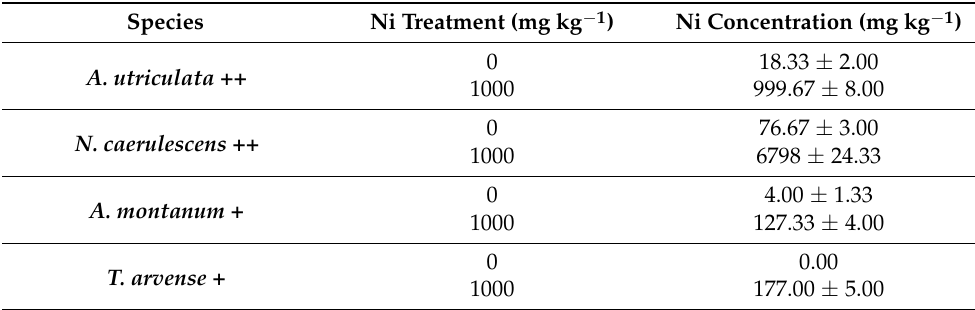
Table 2. X-ray fluorescens chemical analysis of Ni concentration measured on shoots of test species A. utriculata, N. caerulescens, A. montanum and T. arvense . n = 10 each species. ++ hyperaccumulator species, + non-hyperaccumulator species. Species Ni Treatment (mg kg − 1 ) Ni Concentration (mg kg − 1